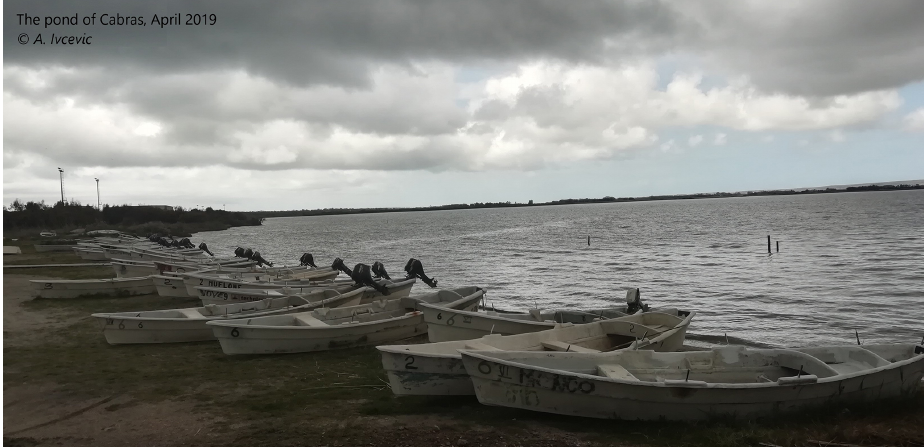
Figure 3. Wetlands of west Sardinia, which are famous for their fishing activities.